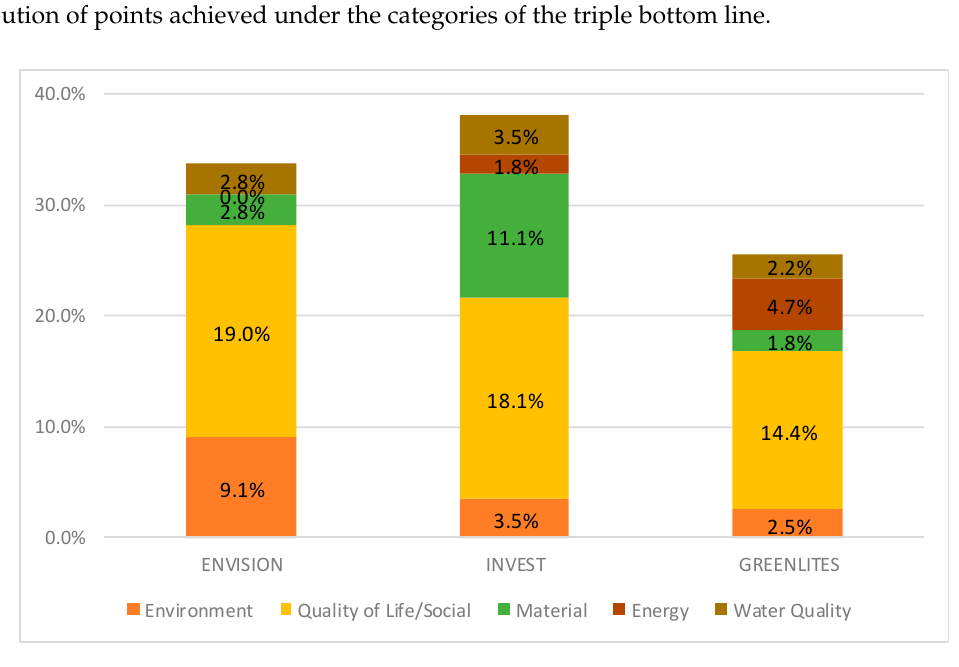
Figure 1. Project 1 ′ s points across each category of the triple bottom line used in this research. Figure 1. Project 1’s points across each category of the triple bottom line used in this